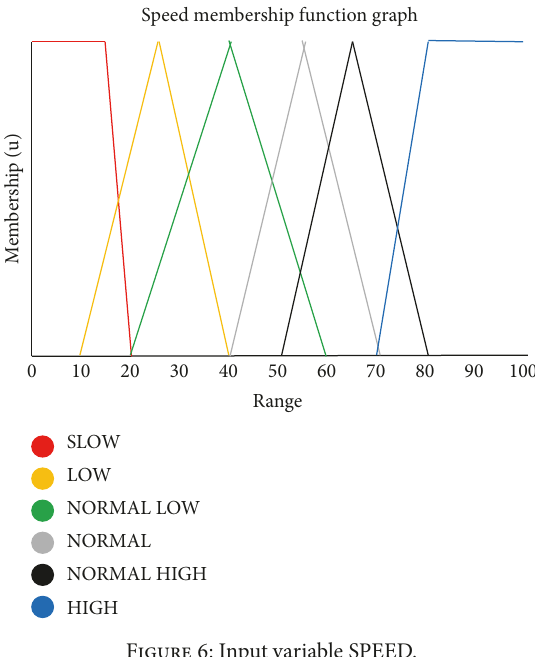
Figure 6: Input variable SPEED.